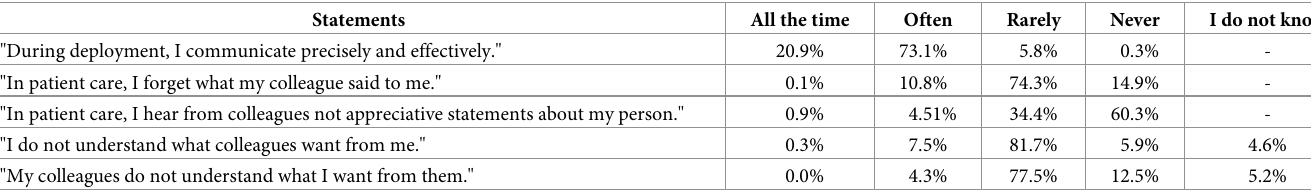
Table 2. Characteristics of communication skills as self-estimated by emergency staff.